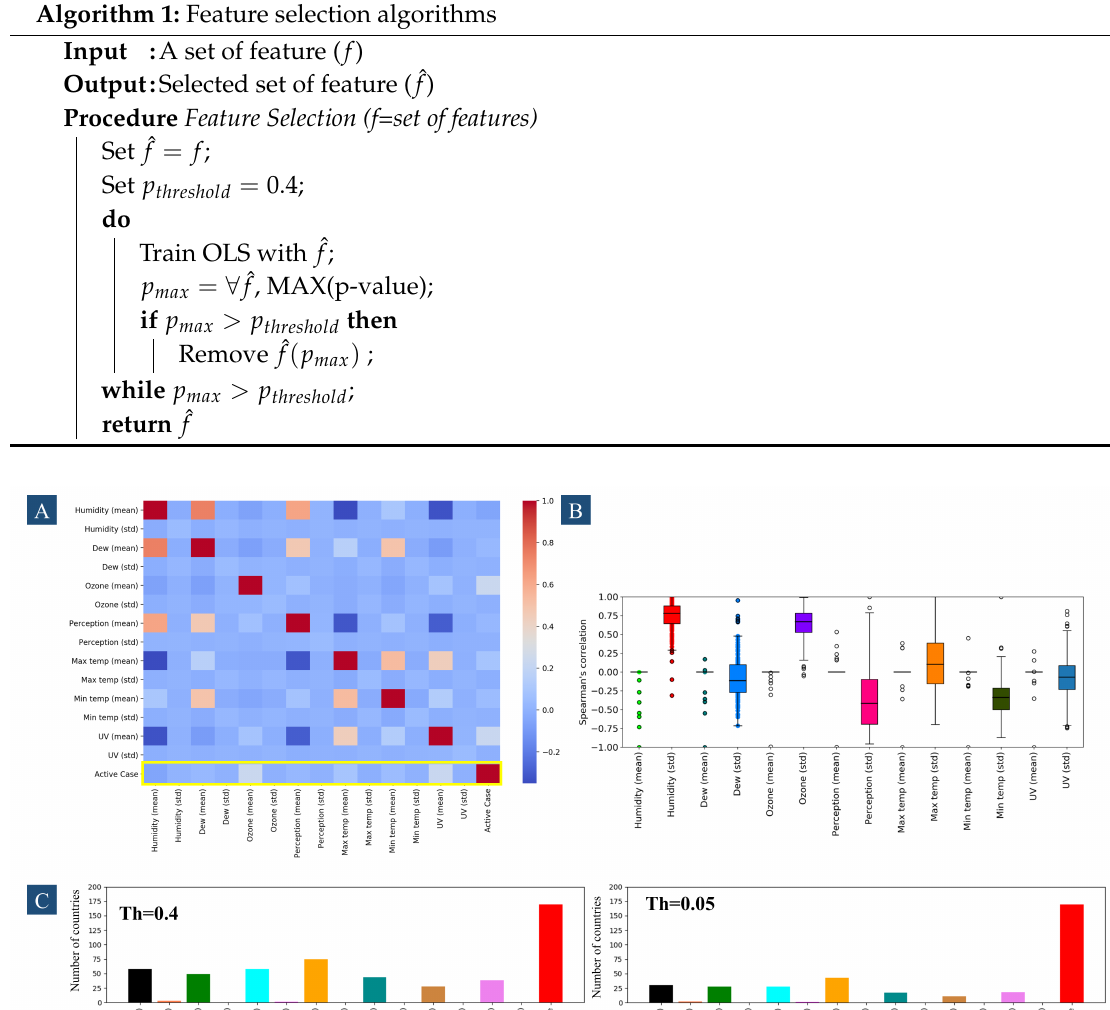
Algorithm 1: Feature selection algorithms